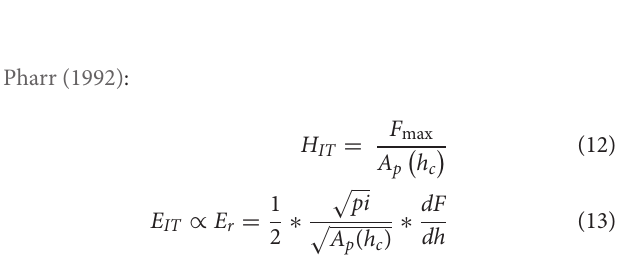
FIGURE 1 | Principle of microindentation hardness testing, during which we measure time ( t ) loading force ( F ), and penetration depth of the indenter ( h ). The resulting F - h curves are employed in determination of indentation modulus ( E IT ) from stiffness ( S ) and indentation hardness ( H IT ) from corrected final penetration depth ( h c < h 2 ) according to Oliver & Pharr theory. The figure also documents clear difference between F - h curves of two samples studied in this work: PCL/PLA/C15-EDI and PCL/PLA/C15-ED (see Table 1 for description of the